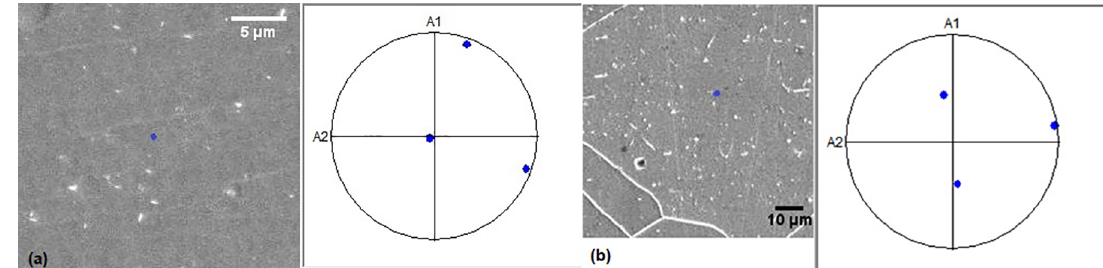
Figure 1. (100) pole figure of S79 and S340 after 100 hours at 150ºC. a) ɛ carbide present in habit plane. b) Cementite and epsilon carbide coexist, each one in its habit plane and growing direction.